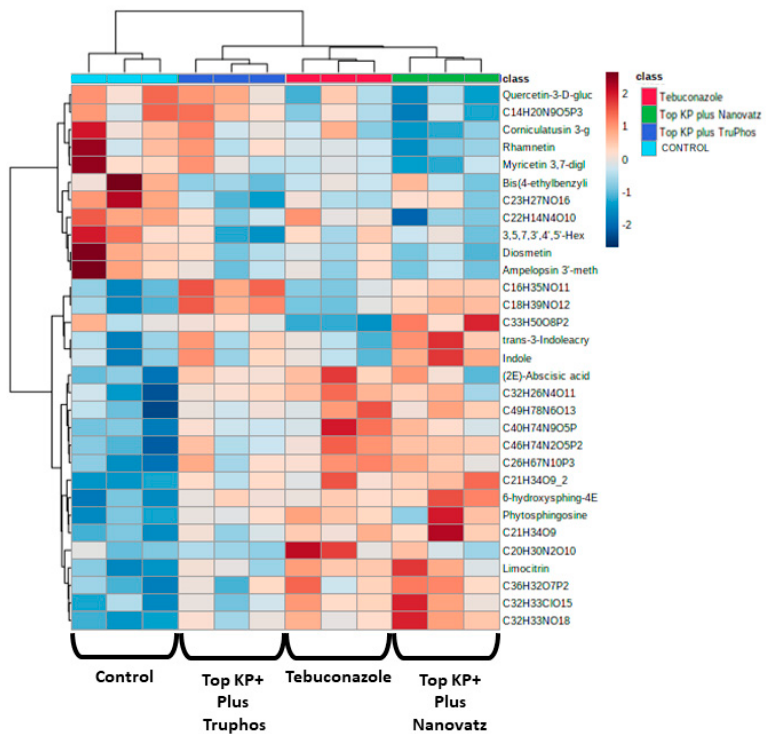
Figure 7. Heatmap and Hierarchical Cluster Analysis graph for all metabolites significantly ( p < 0.05, TukeyKramer HSD test) up-produced or down-produced in grape skins of cv. Carignan in the fungicide Folicur (tebuconazole) 0.02%, the fertilizers Top KP+ 1% plus Nanovatz 0.1%, or Top KP+ 1% plus TruPhos 0.25% and the control untreated treatments samples. The X -axis represents three repetitions of each treatment.